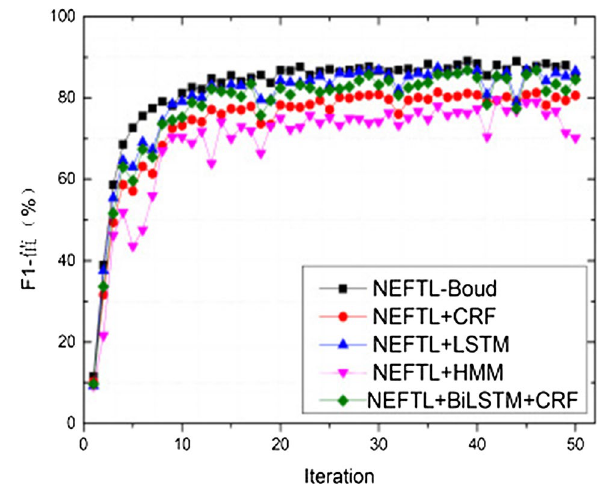
Fig. 5 Model training fitting